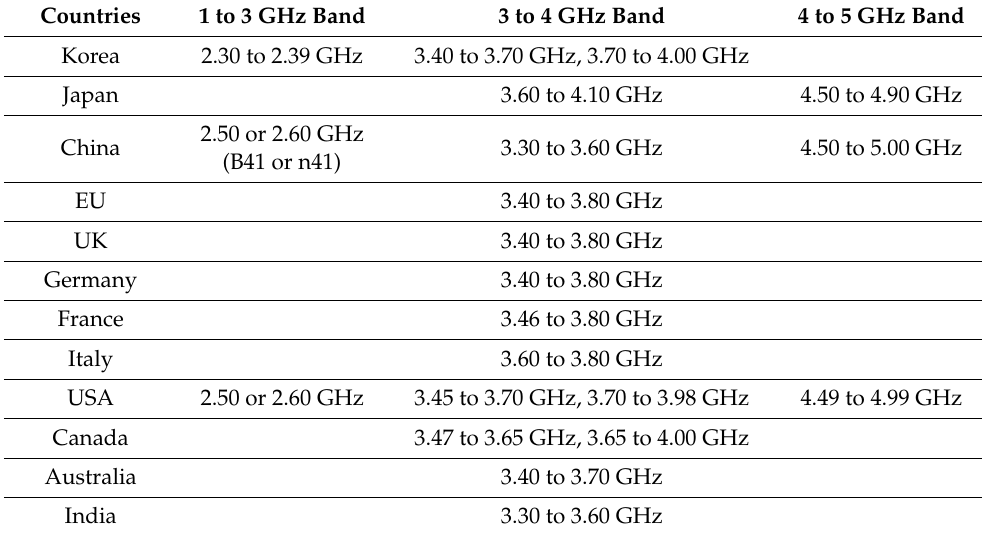
Table 1. Sub-6 GHz mid-band spectrum. Reprinted from ref. [7].